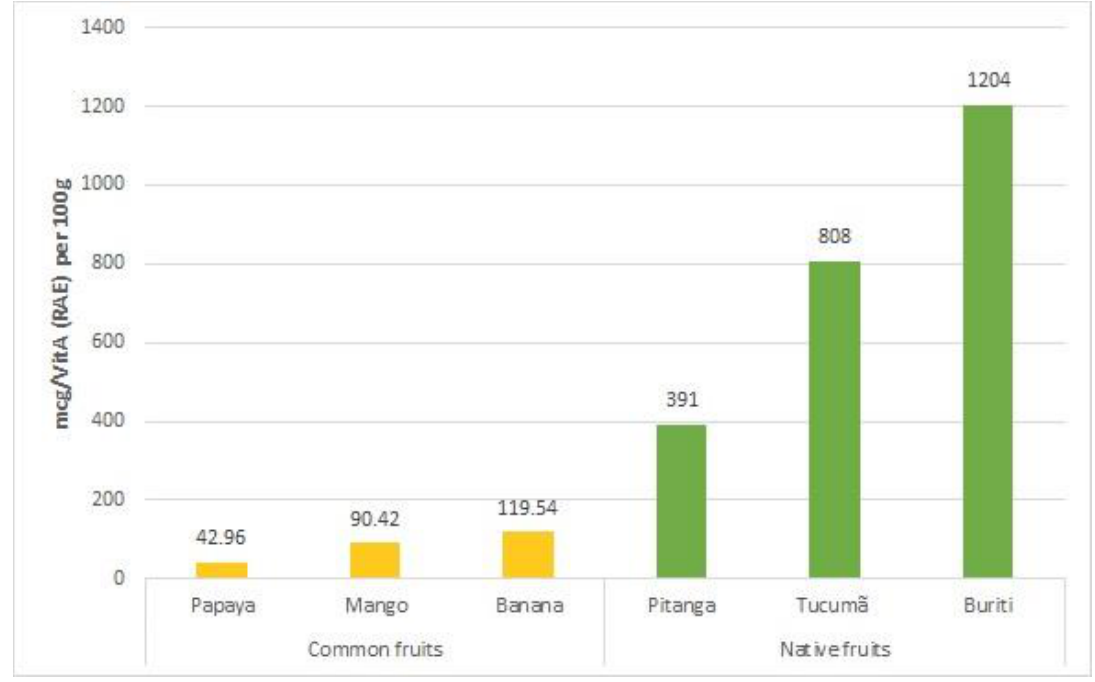
Figure 2. Vitamin A content (expressed in mcg RAE per 100g of fresh raw pulp/whole fruit, with or without peel) of the native Brazilian fruits pitanga ( Eugenia uniflora ), tucumã ( Astrocaryum aculeatum ) and buriti ( Mauritia flexuosa ) compared to more commonly available vitamin A-rich fruits. Source: Brazilian food composition tables [58] and the System on Brazilian Biodiversity (SiBBr) database [59].